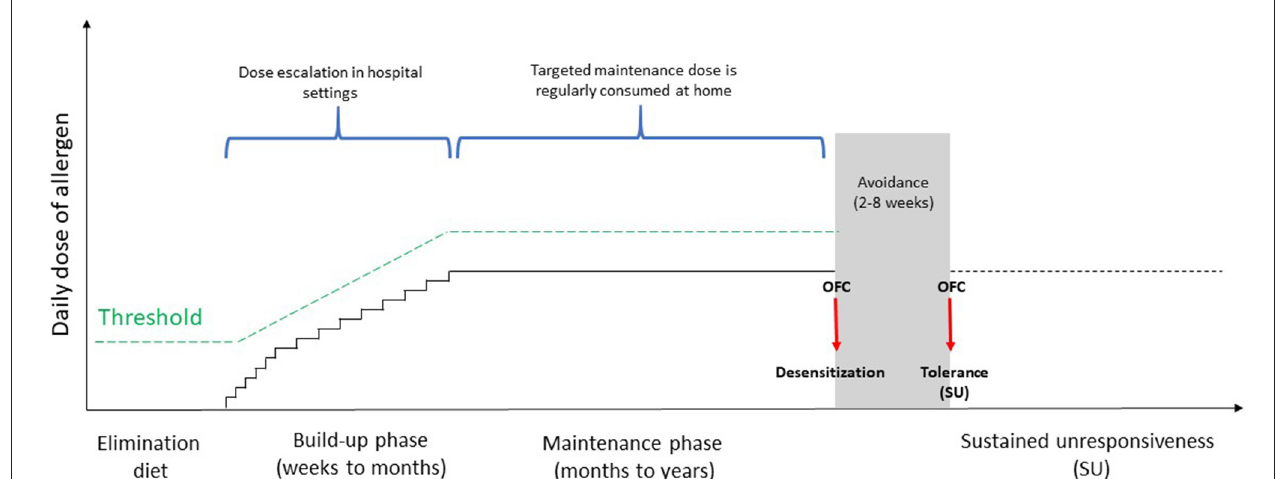
FIGURE 1 | Classic protocol of oral immunotherapy. OFC, oral food